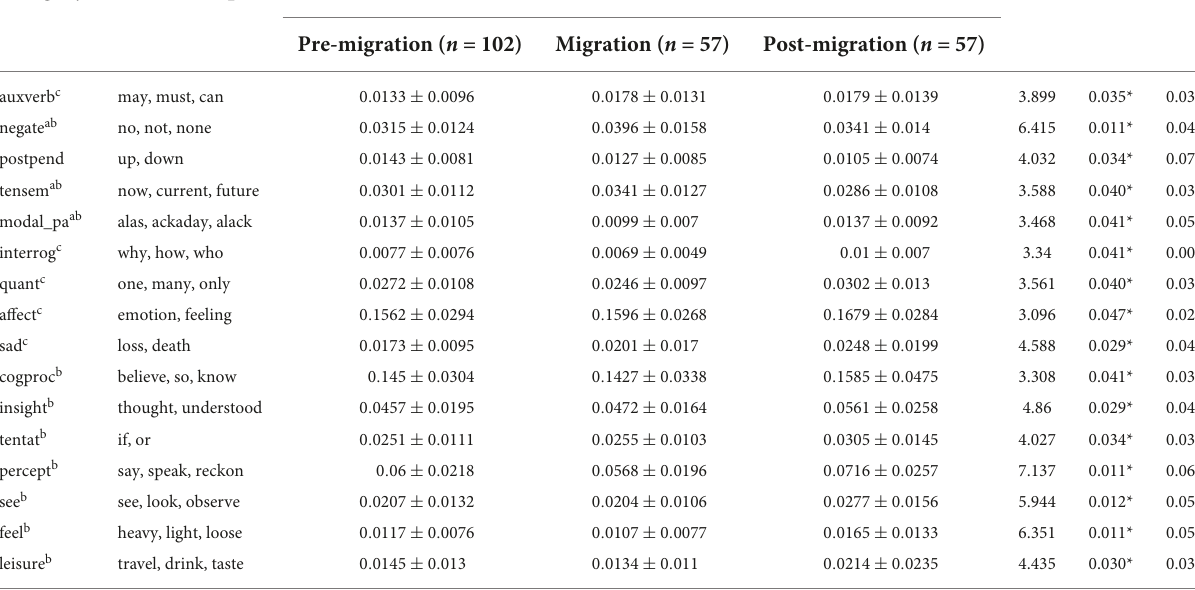
TABLE 1 Differences in the frequencies of different categories of words used in the three groups.